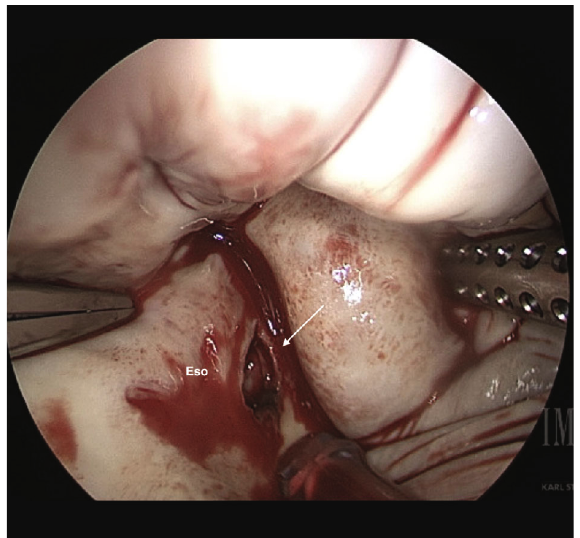
Figure 4: Esophageal injury. Eso: Esophagus. Arrow: 2 × 1 : 5